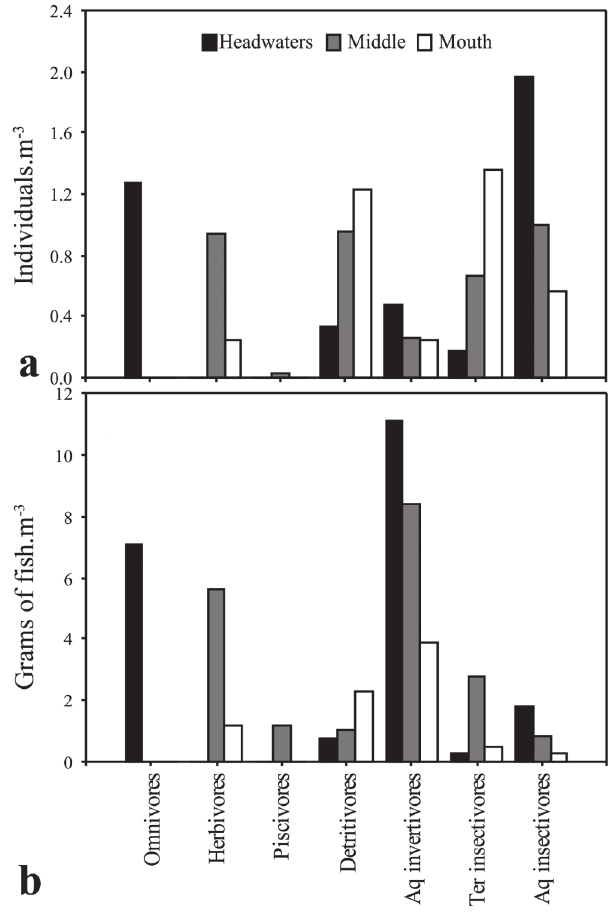
longitudinal gradient of the Vermelho River, East Atlantic basin, Antonina, Paraná State, Brazil. Aq = aquatic; ter =